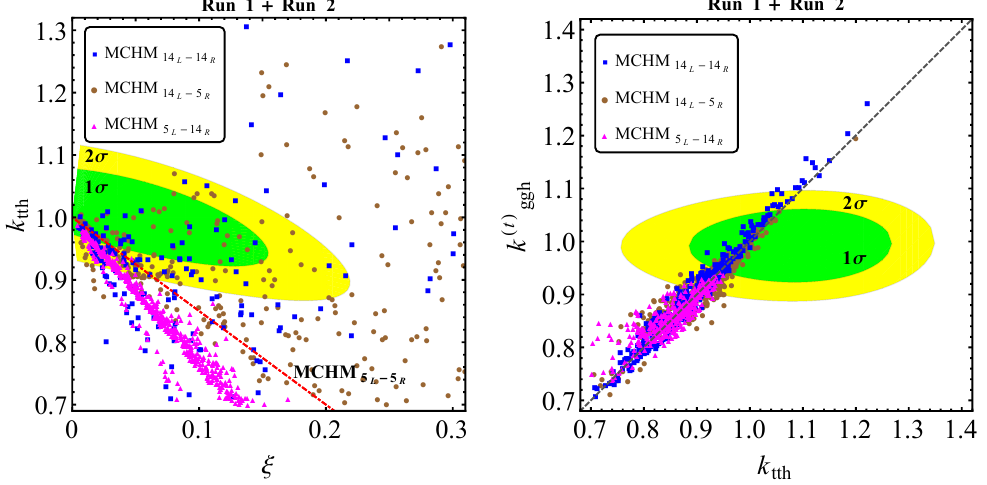
Figure 5. We present the regions in the k (cid:0) (cid:24) and k ( t ) (cid:0) k planes allowed at 68% (green) tth tth ggh and 95% (yellow) CL using combined Run 1 and available Run 2 data. In the left panel the red line corresponds to MCHM 5 . On the right panel, the grey dashed line corresponds to (cid:14) t = 0. L (cid:0) 5 R Valid ‘extended model’ points are observed to lie within the experimentally allowed regions.